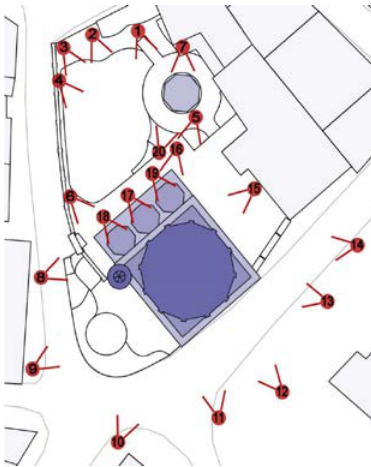
Figure 3. The schema of ground-based photogrammetric survey acquisition